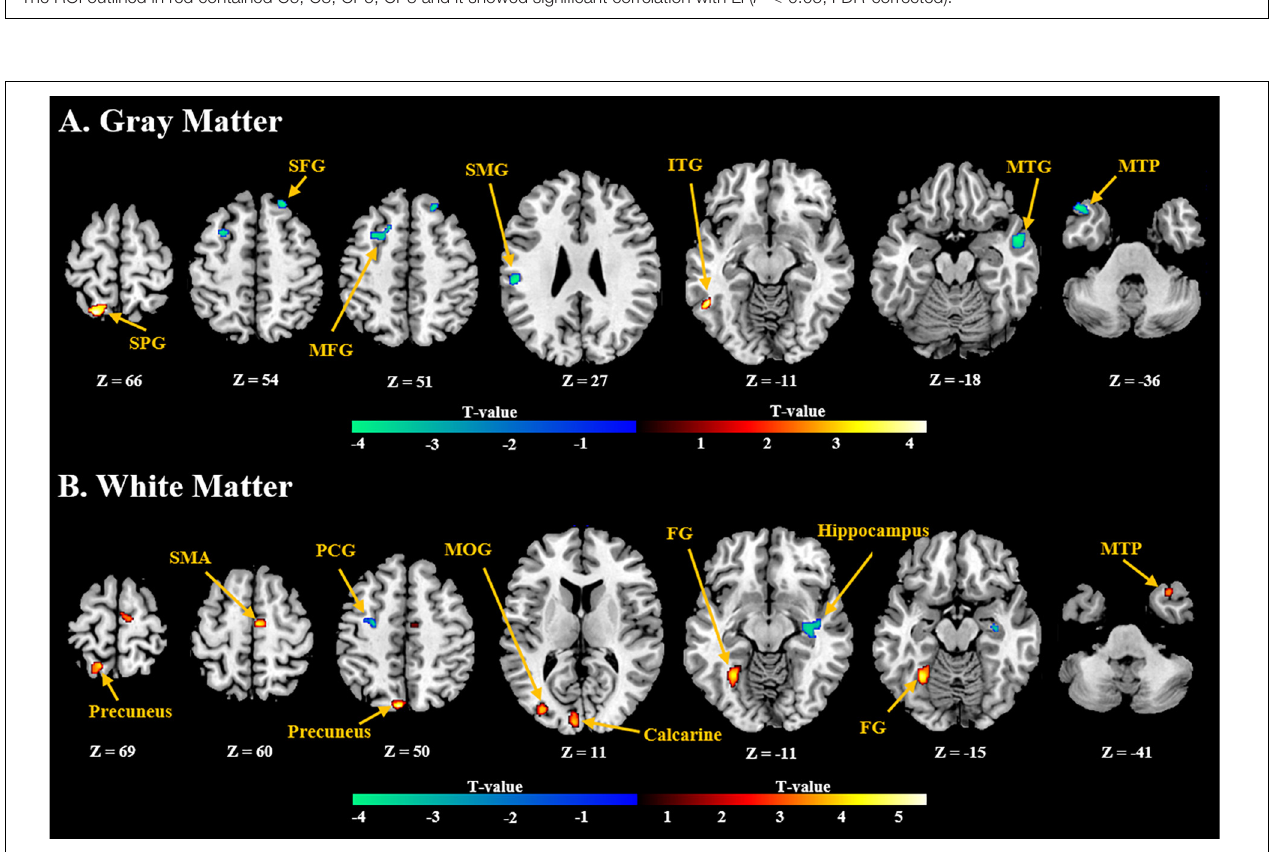
FIGURE 3 | Brain regions with (A) gray and (B) white volumes which show significant positive (red) or negative (blue) correlation with the NFB learning index LI ( P < 0.005, Cluster size > 50). SPG, Superior Parietal Gyrus; SFG, Superior Frontal Gyrus; MFG, Middle Frontal Gyrus; SMG, Supramarginal Gyrus; ITG, Inferior Temporal Gyrus; MTG, Middle Temporal Gyrus; MTP, Middle Temporal Pole; SMA, Supplementary Motor Area; PCG, Postcentral Gyrus; MOG, Middle Occipital Gyrus; FG, Fusiform